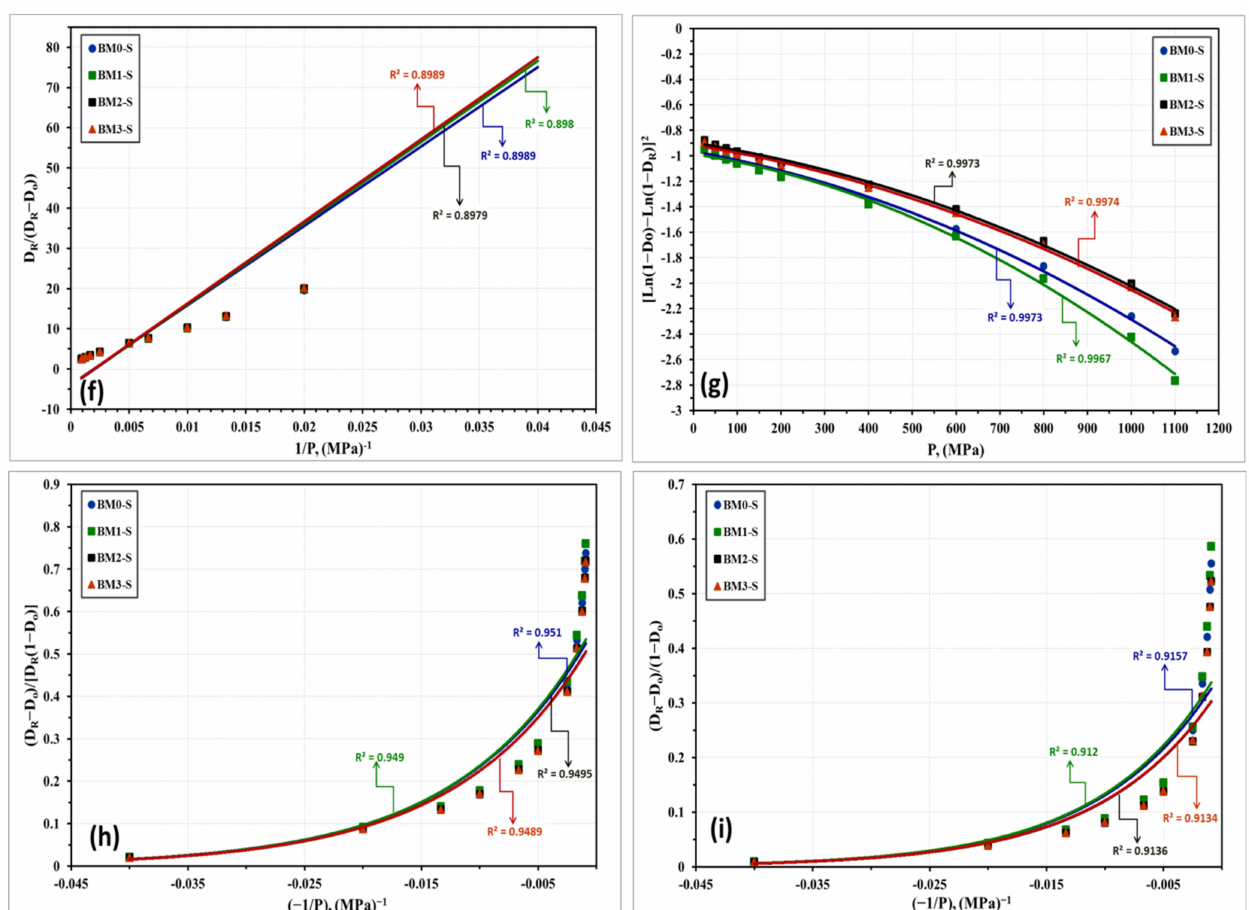
Figure 11. Compressibility results of the stress-relieved samples BM0-S, BM1-S, BM2-S, and BM3-S alloy samples obtained from: ( a ) compressibility experiments conducted on these alloys. ( b – i ) the compressibility results obtained empirically from applying models (1) through (8), one-to-one. Table 4. The estimated factors related to the models applied on the alloys investigated in the present study. Applied